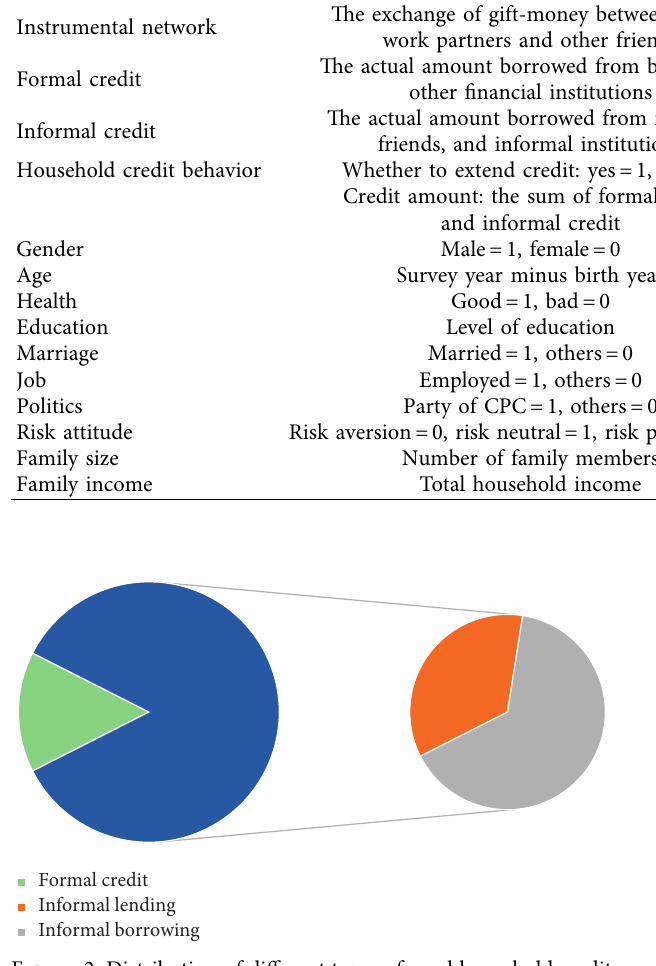
Figure 2: Distribution of different types of rural household credit